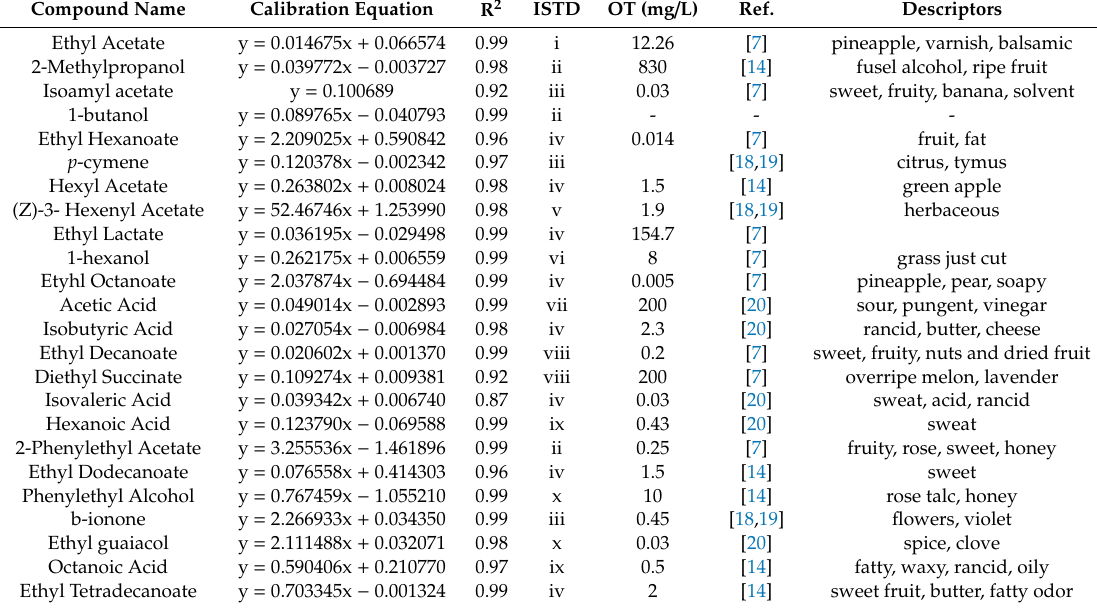
Table 2. Compound names, calibration curve, R 2 , and internal standard used for the determination of each volatile compound. List of internal standards (ISTD): (i) ethyl acetate D8; (ii) butanol D10; (iii) o-xylene D10; (iv) ethyl hexanoate D11; (v) butanol D10 acetate D3; (vi) 5-methylhexanol; (vii)